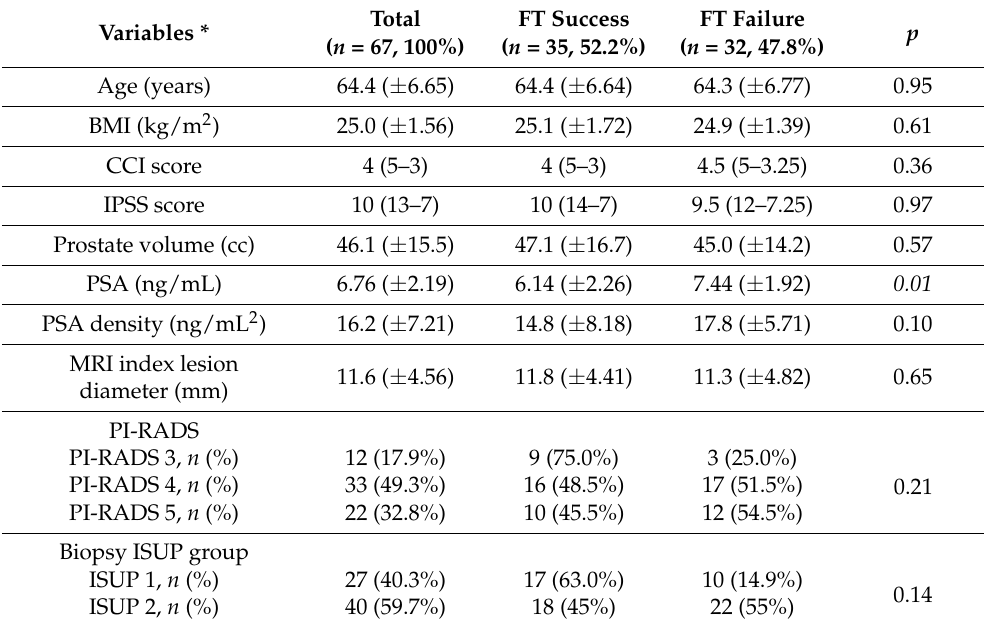
Table 1. Clinicopathologic features of our